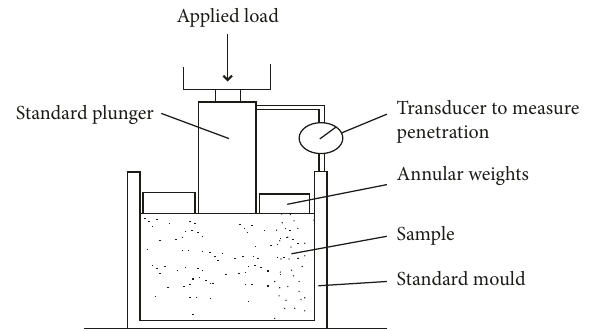
Figure 1: A schematic diagram of the CBR test.